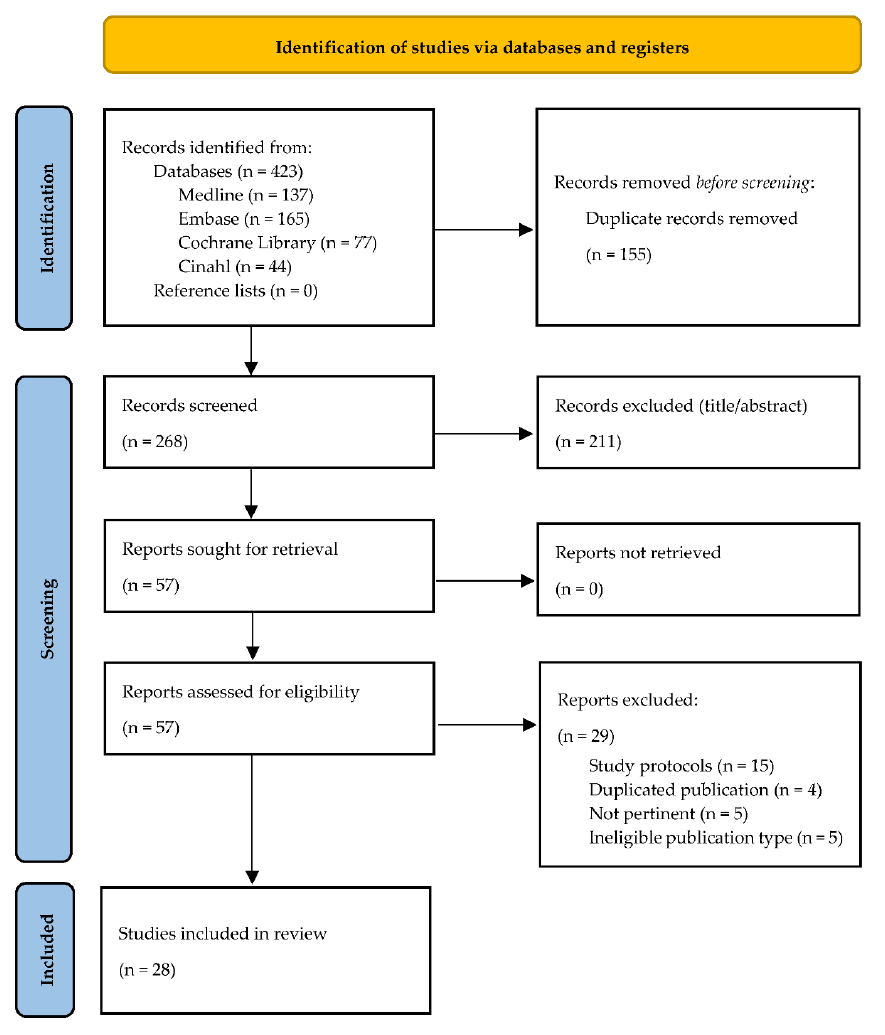
Figure 1. PRISMA flowchart of the study selection process. Table 1. OCEBM Level of Evidence 2011